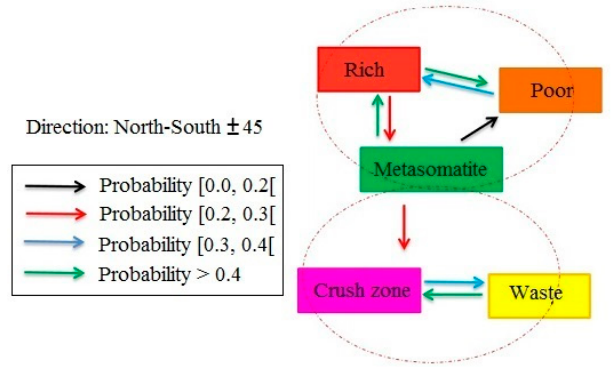
Figure 11. Preferential relationship schemes in North-South direction (45 ˚ tolerance). The top section